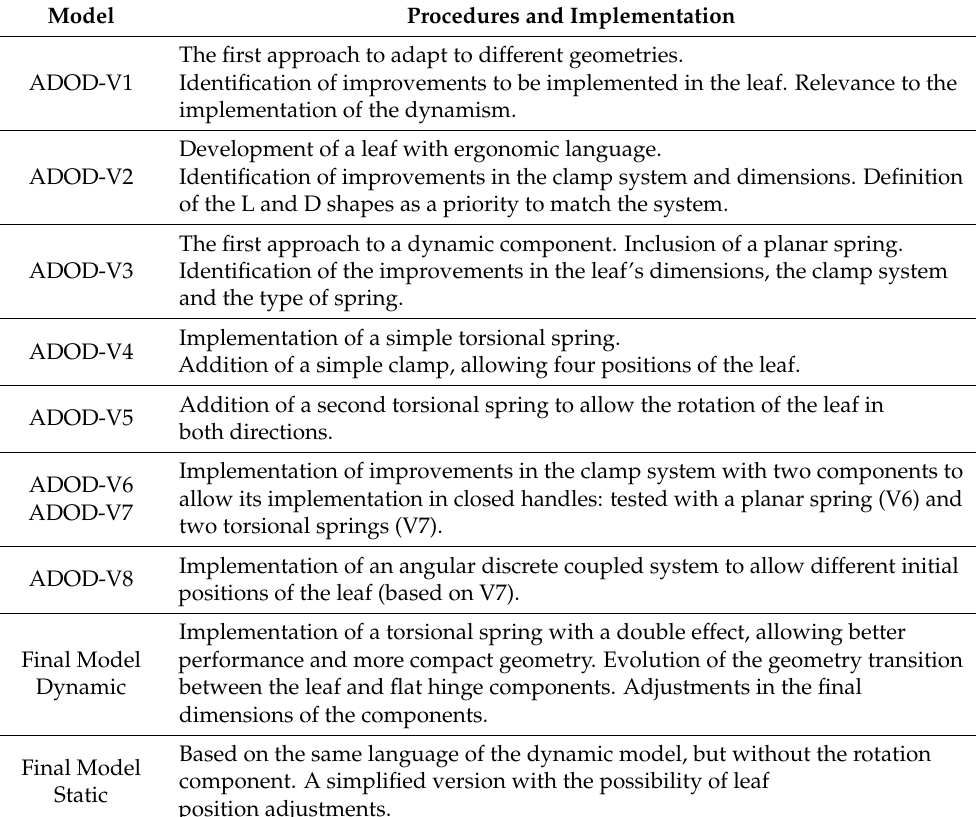
Table 1. The predisposition of the participants to the use of